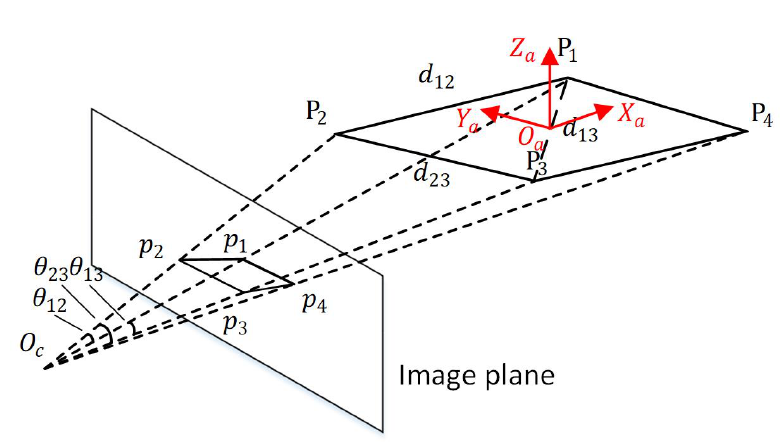
Figure 4. The projection of the reference points and three constraints of